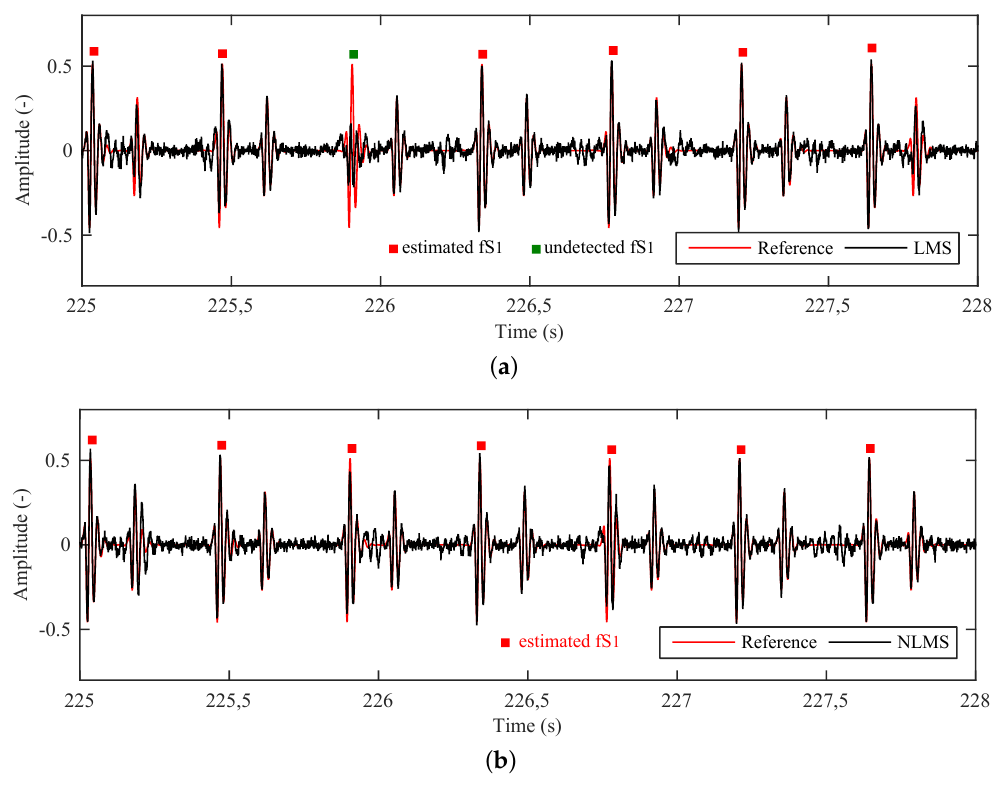
Figure 15. Detailed analysis of output from the adaptive system using ( a ) the LMS; and ( b ) the NLMS